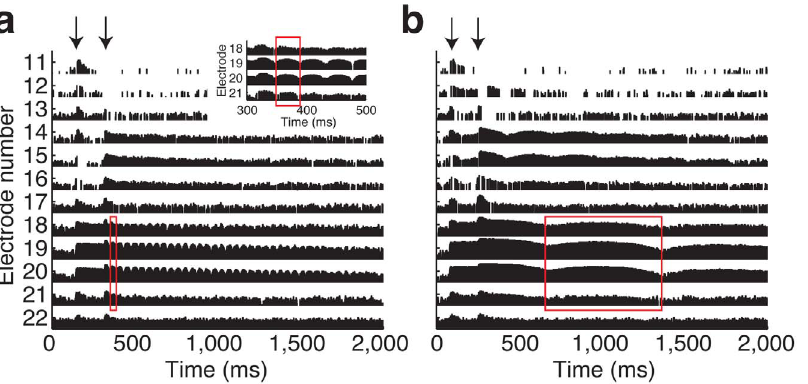
Figure 2. Electrodogram of a CI speech processor output to an out-of-tune and in-tune guitar. Time is represented on the x-axis. Electrode number is on the y-axis. Electrodes 1–11 contained only a small minority of the stimulation pulses and are not shown. The height of each vertical bar in the plot reflects the normalized amplitude of a single stimulation pulse. The red rectangles on each plot highlight a single period of amplitude modulation that is present across multiple electrodes. ( a ) Out-of-tune harmonics from strings 3 and 4. The inset, upper right, shows an expanded view of a short time segment to reveal the details in the amplitude modulation of the stimulation pulses. ( b ) In-tune.